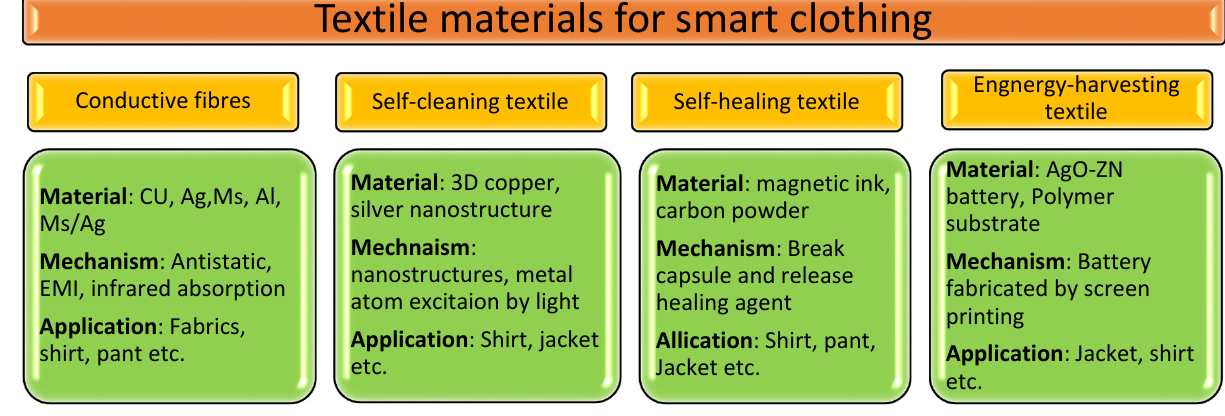
Figure 9. Classification of textile materials for smart clothing.